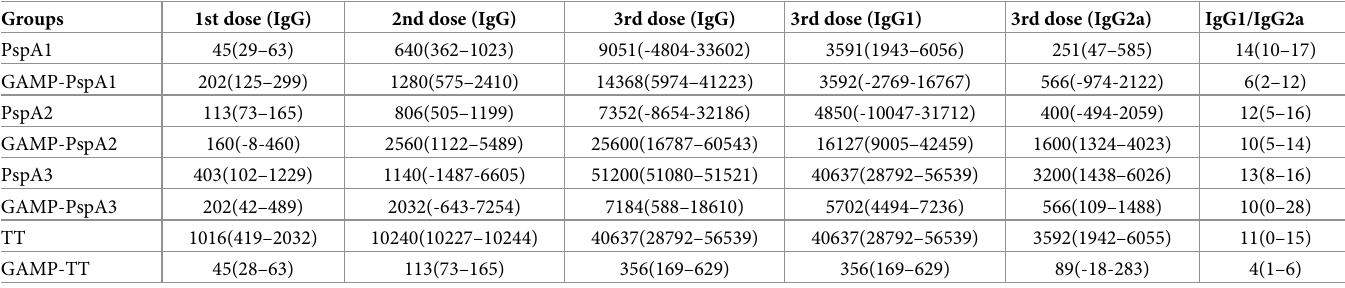
Note: The results were expressed as the reciprocal of geometric mean titer (GMT).